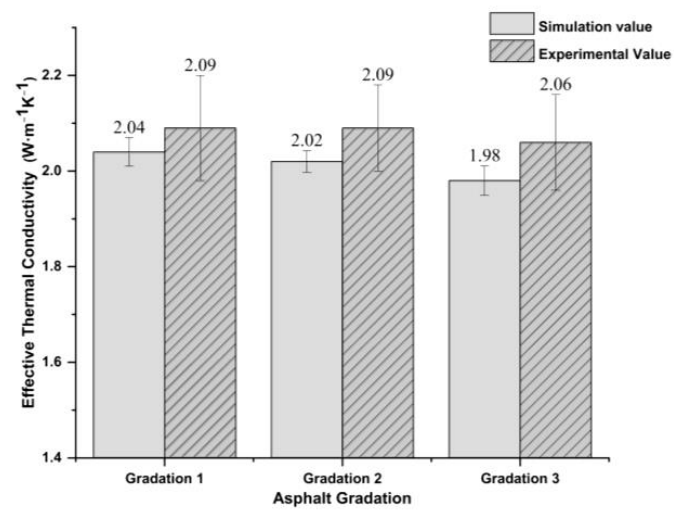
Figure 10. Prediction results for thermal conductivity. Table 2. The prediction error of some 2D thermal conductivity prediction models.